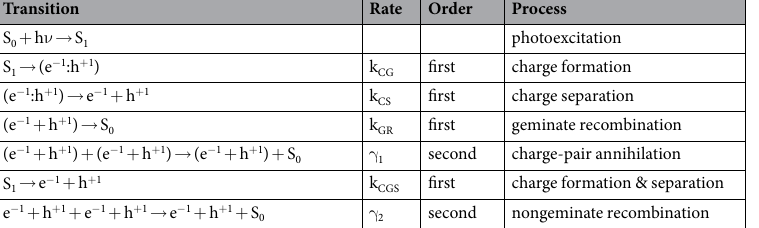
Table 1. The transition and processes, occurring within PBDTfDTBO, PBDTfDTBT, and PBDTfDTBSe blends, with their reaction orders. S 1 are excitons generated by light absorption, (e − 1 :h + 1 ) is a coulombically bound charge pair (CT state), (e − 1 + h + 1 ) is a loosely bound charge pair, e − 1 + h + 1 are free electron and holes.